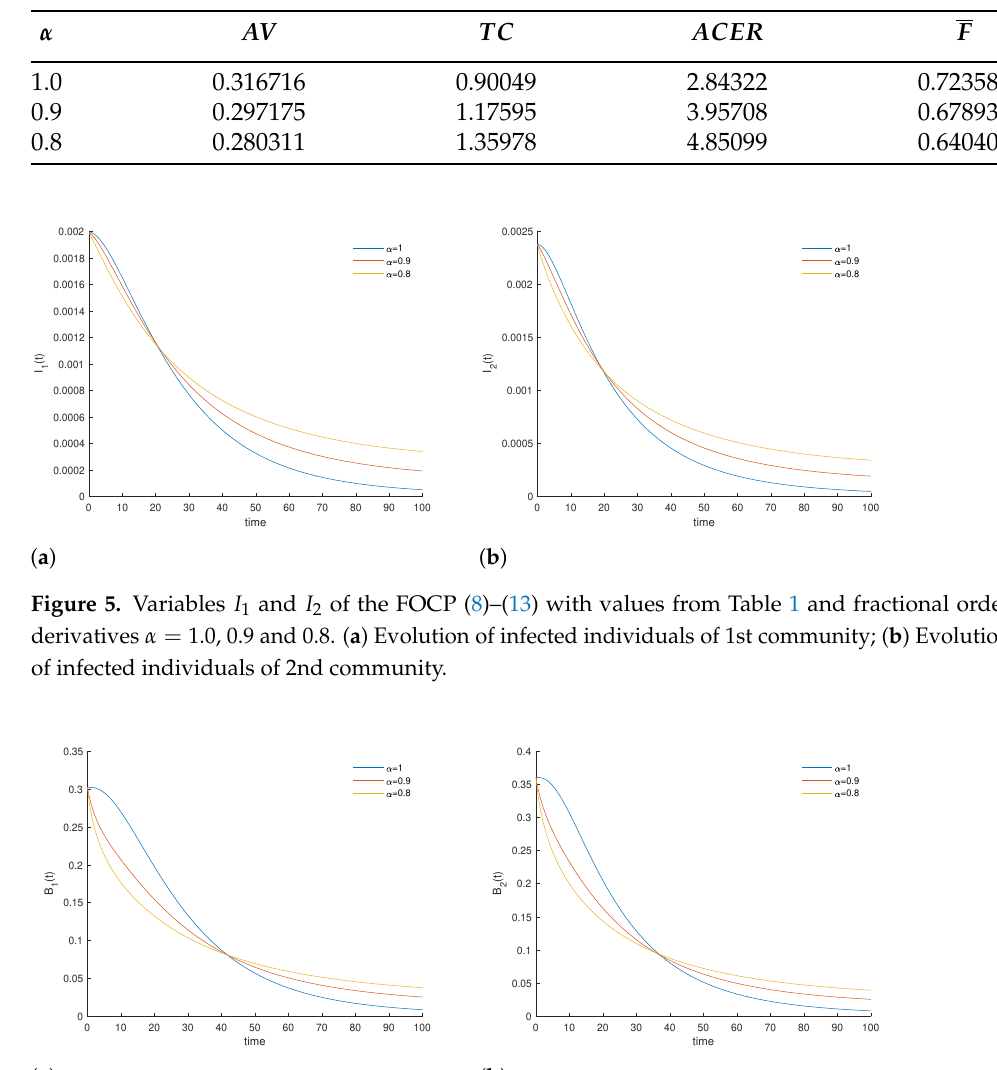
Table 4. Summary of cost-effectiveness measures for classical and fractional (0 < α < 1) cholera disease optimal control problems. Parameters according to Tables 1 and 3 with C 1 = C 2 = 1.